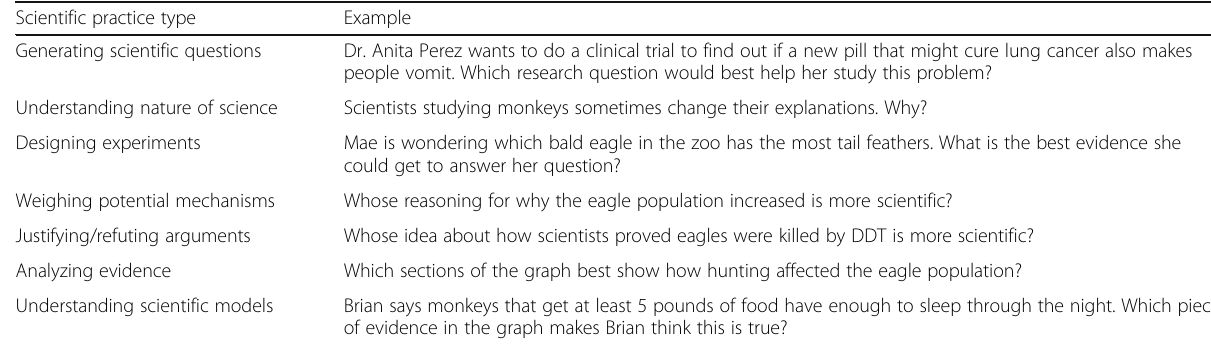
Table 3 Examples of each scientific practice type in the scientific sensemaking